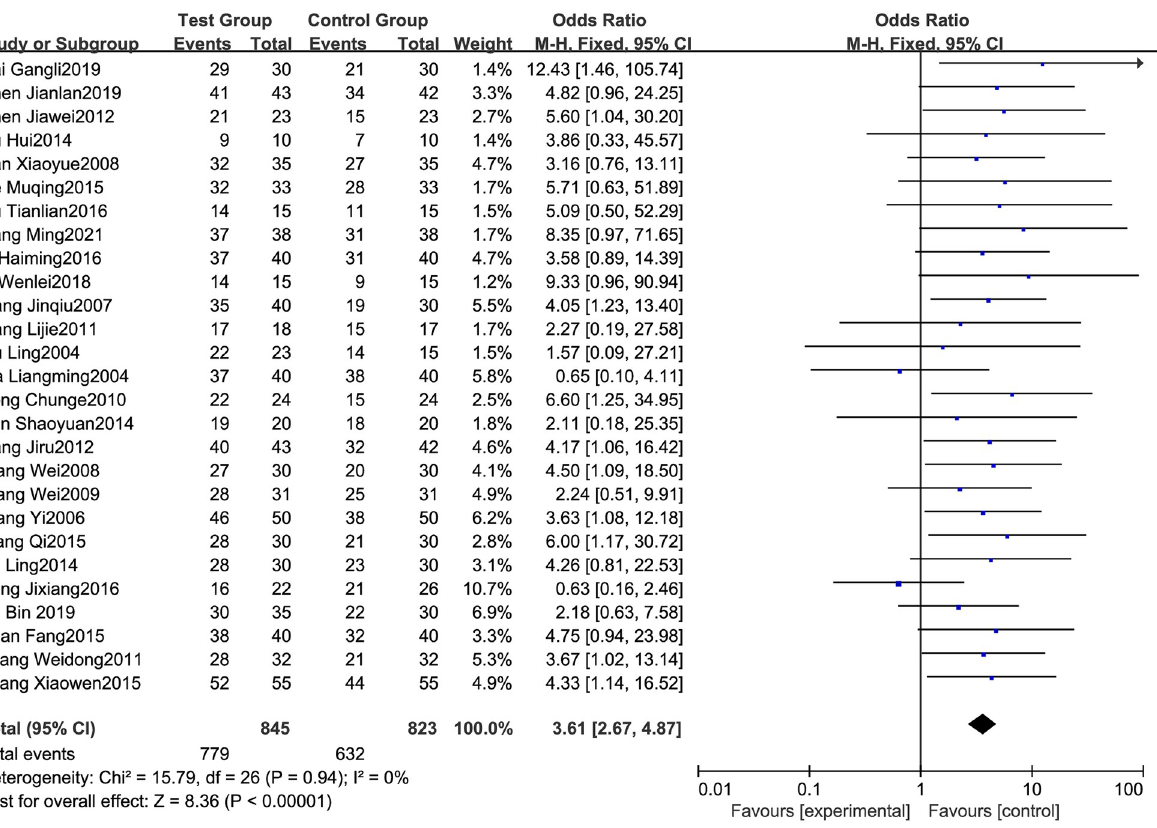
Fig 3. Forest plot of the effective rate.